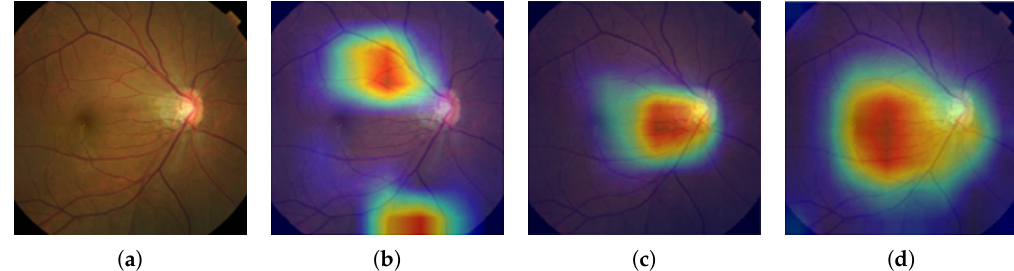
Figure 4. Localization results produced by the different models for the input image shown in ( a ). ( b ) shows the (wrong) localization result produced by VGG-16-M. ( c ) shows the (correct) localization result produced by Inception-v4-M, and ( d ) shows the (correct) localization result produced by